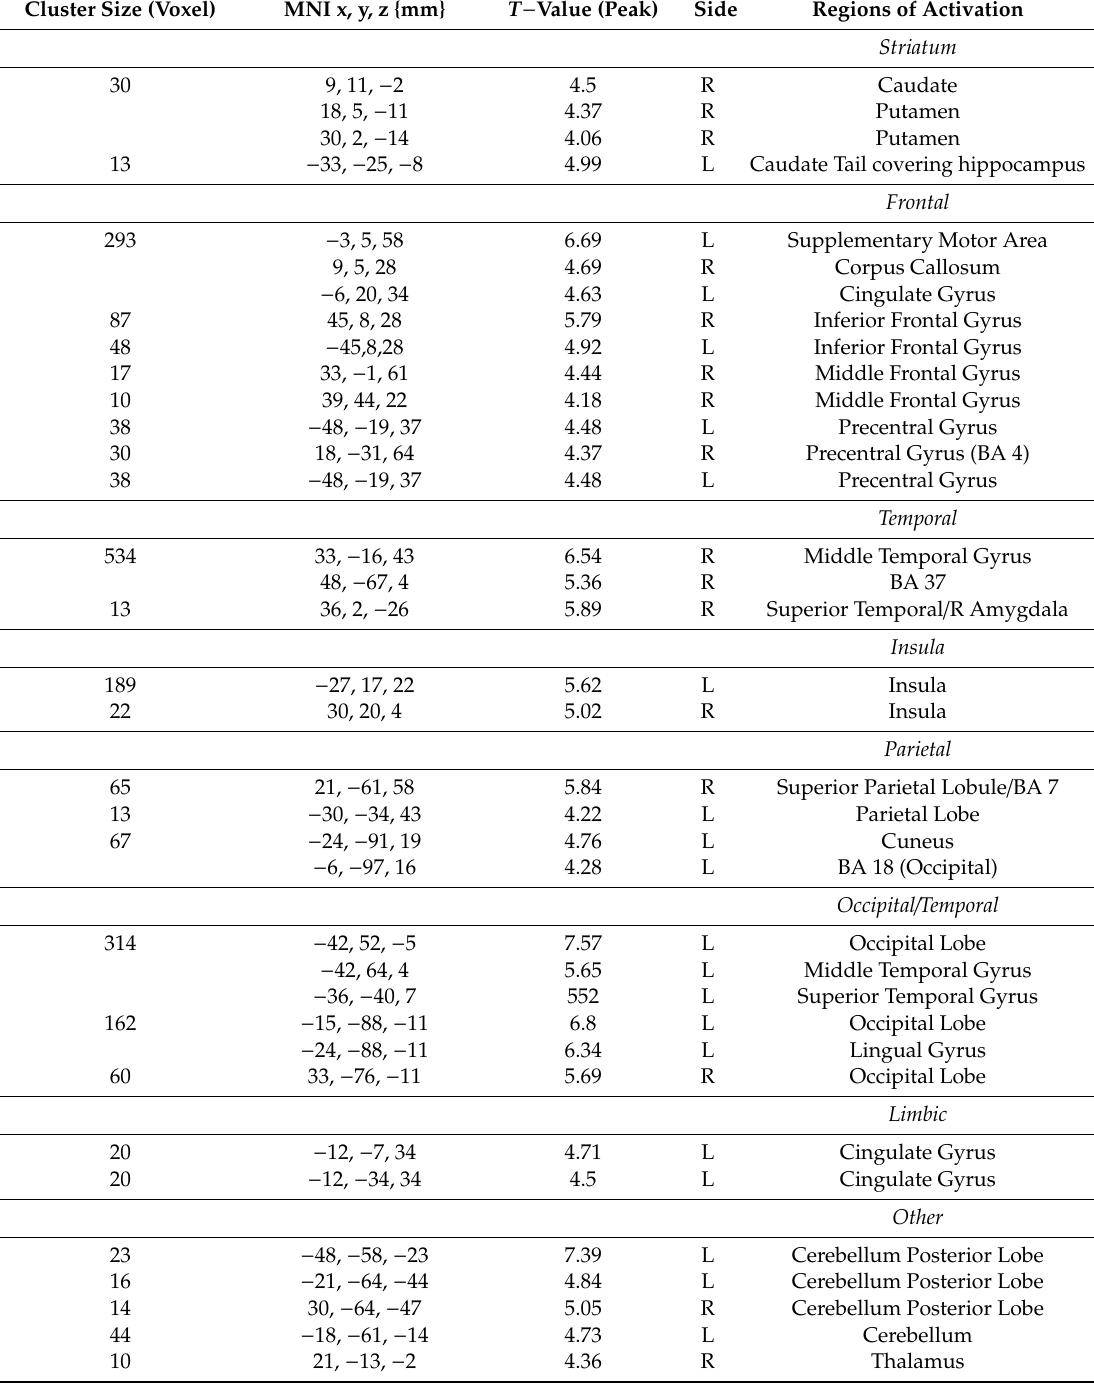
Table 5. PPI analysis for Novel CS > Familiar CS 1